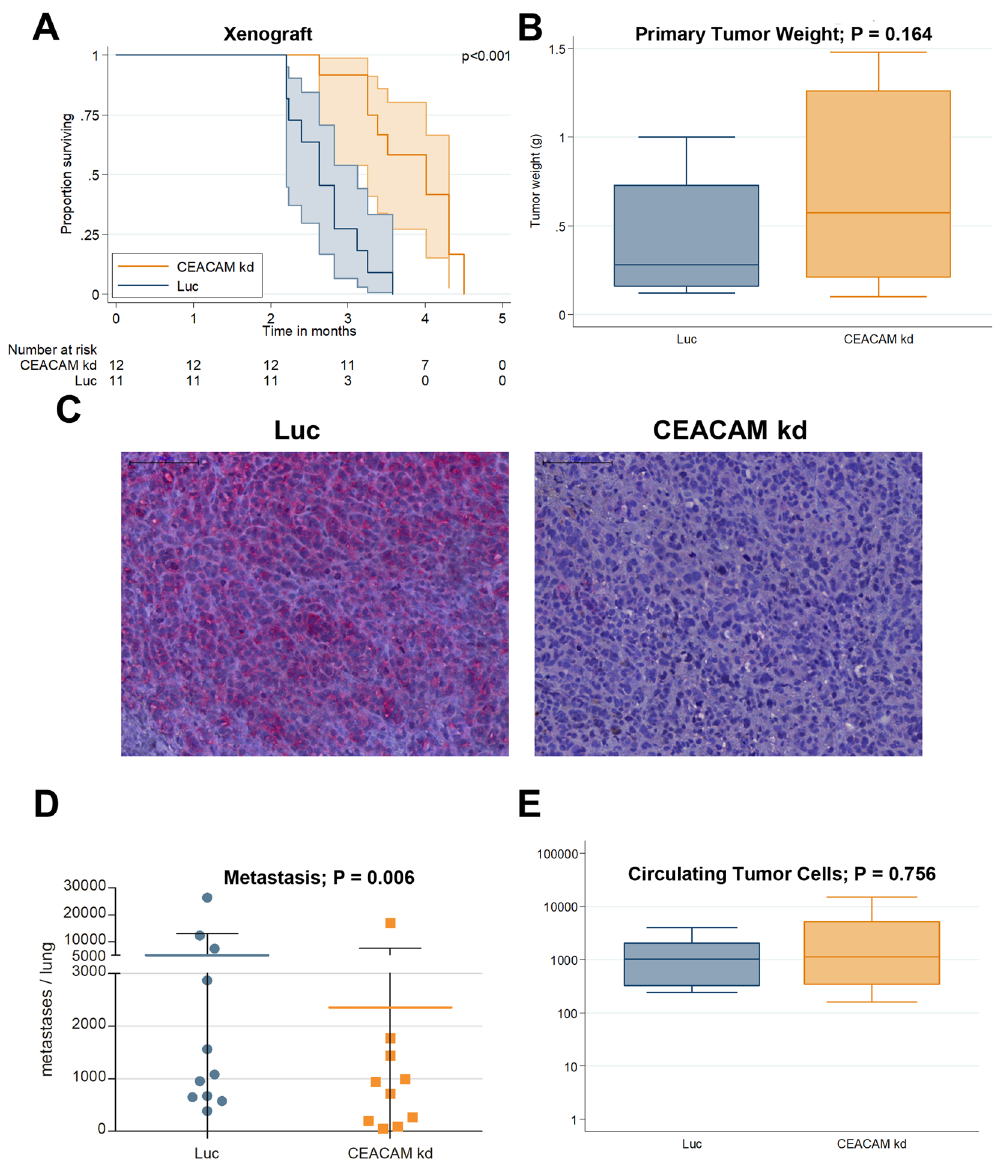
Figure 2. Spontaneous metastasis xenograft model of human melanoma. ( A ) Kaplan-Meier overall-survival analysis (OS) for scid mice with subcutaneously injected MeWo cells revealed significantly prolonged OS in mice inoculated with MeWo CEACAM1 kd 1 against MeWo Luc inoculated animals (p < 0.001). ( B ) Tumor weight at the time of death was not significantly different between the two groups (p = 0.164; n = 11 Luc group and n = 12 CEACAM kd group). ( C ) Immunohistochemical staining of paraffin embedded tumor tissue (xenograft MeWo tumors in scid mice) for CEACAM1 demonstrated the stability of the CEACAM1 knockdown in the subcutaneous tumors: High CEACAM1 was detected in the MeWo Luc tumors (left panel) whereas little to no CEACAM1 (in red) could be shown in the MeWo CEACAM1 kd tumors (right panel). scale bar: 100 µ m. ( D ) Knockdown of CEACAM1 significantly decreases metastasis (adj. for survival time and tumor weight; p = 0.016; n = 11 Luc group and n = 10 CEACAM kd group). ( E ) CEACAM1 knockdown does not significantly alter the number of circulating tumor cells in the blood of scid mice (p = 0.756, n = 10 each group). Quantification of circulating (human) tumor cells in the blood of scid mice inoculated with MeWo CEACAM1 kd (orange) compared with controls (MeWo Luc, teal) by quantitative real-time